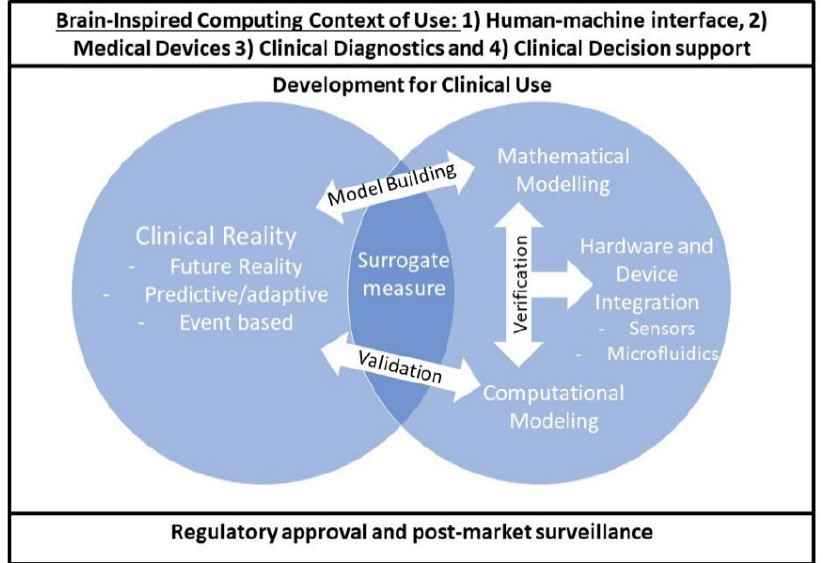
Figure 2. Proposed a framework for the ideation and realization of brain-inspired computing in medicine.